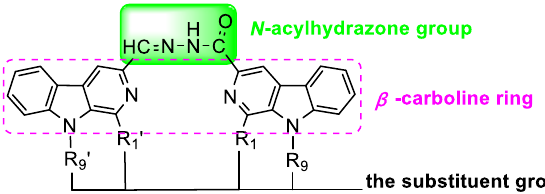
Figure 3. Hybrids of β-carboline and acylhydrazone fragments giving the target heterobivalent β-carbolines.